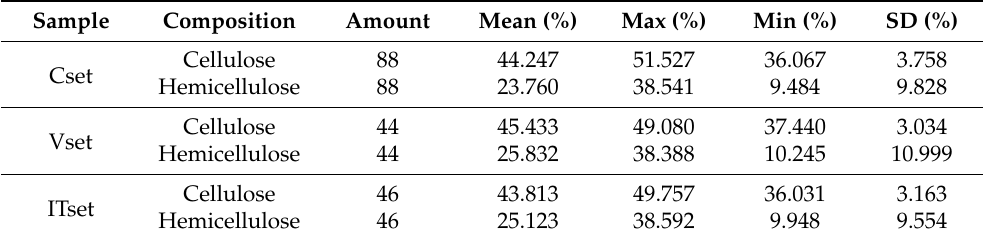
Table 1. Content distribution of sample set.